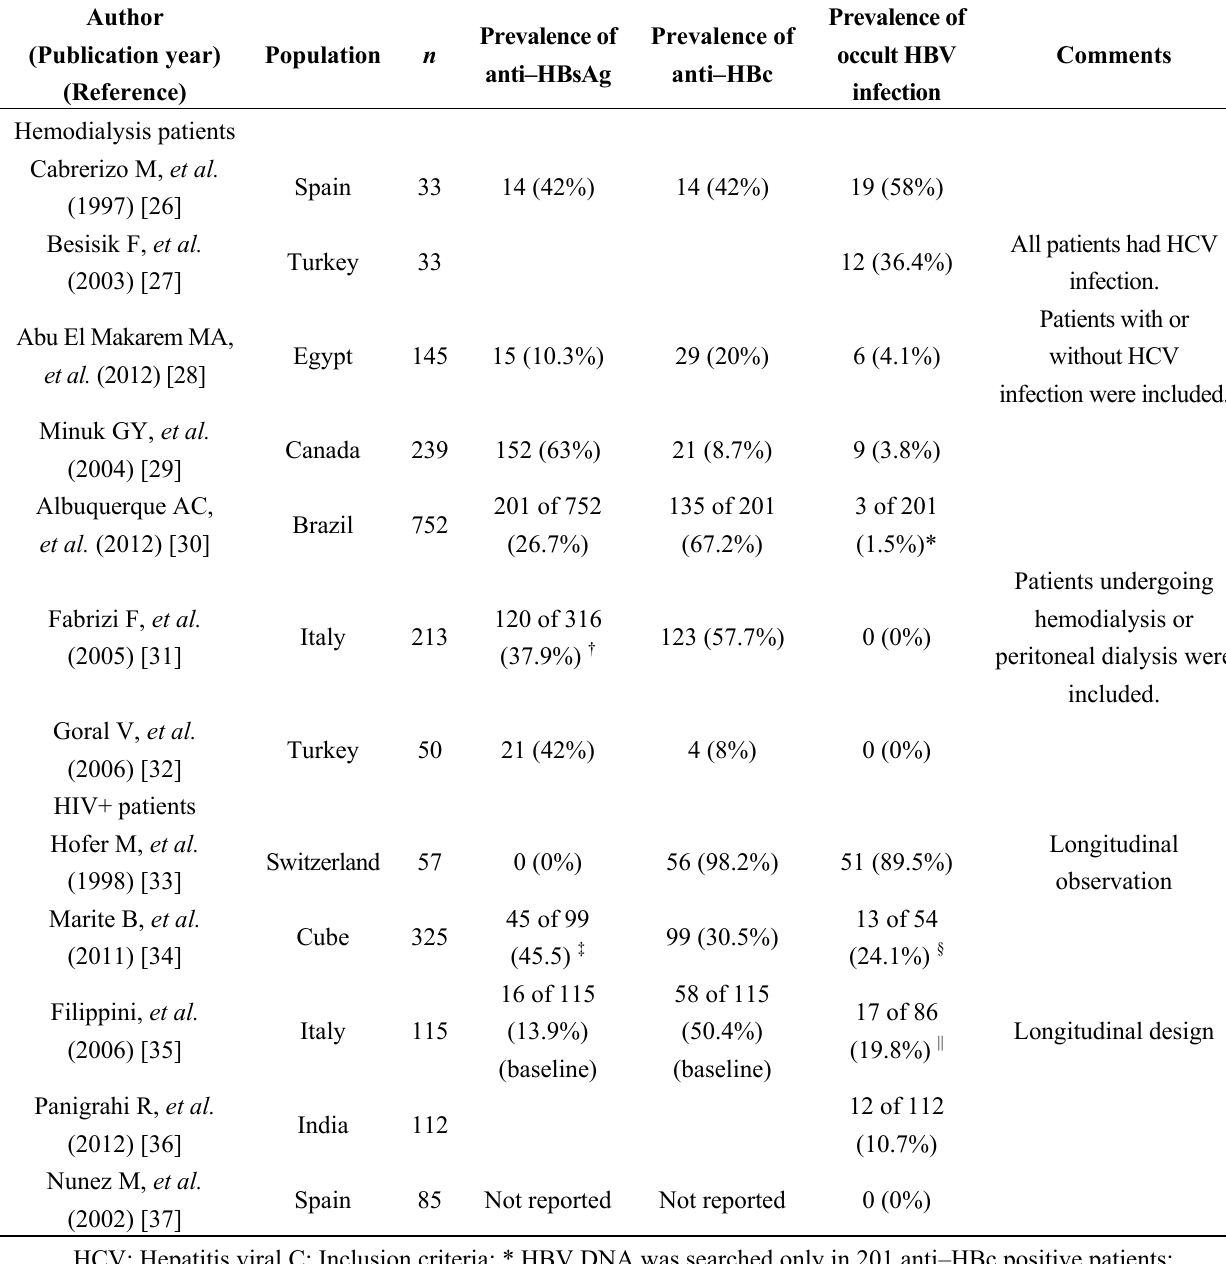
Table 1. Prevalence of occult hepatitis B virus infection (OBI) in hemodialysis and human immunodeficiency virus (HIV)